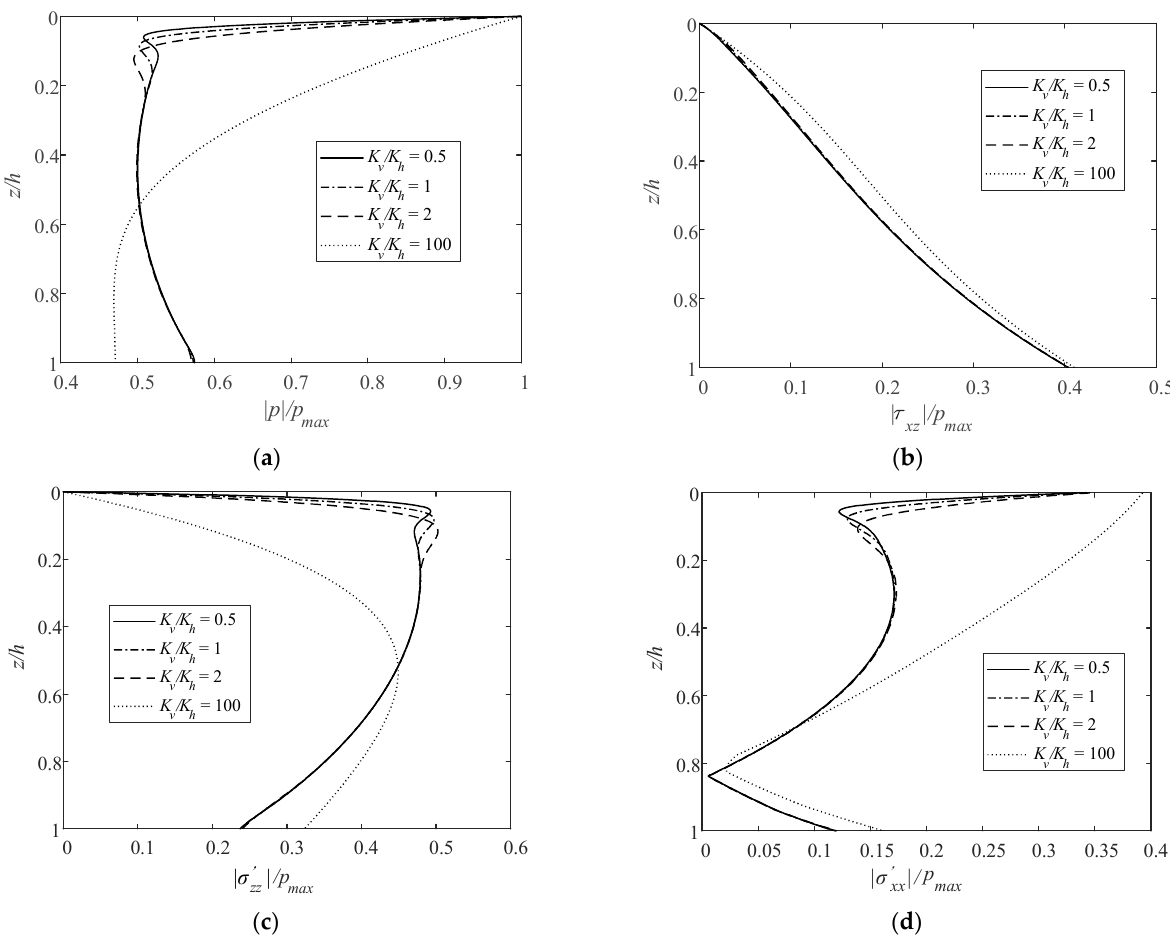
Figure 9. Vertical distributions of normalized maximum ( a ) pore pressure, ( b ) shear stress, ( c ) vertical effective stress, and ( d ) horizontal effective stress by varying K v / K h .